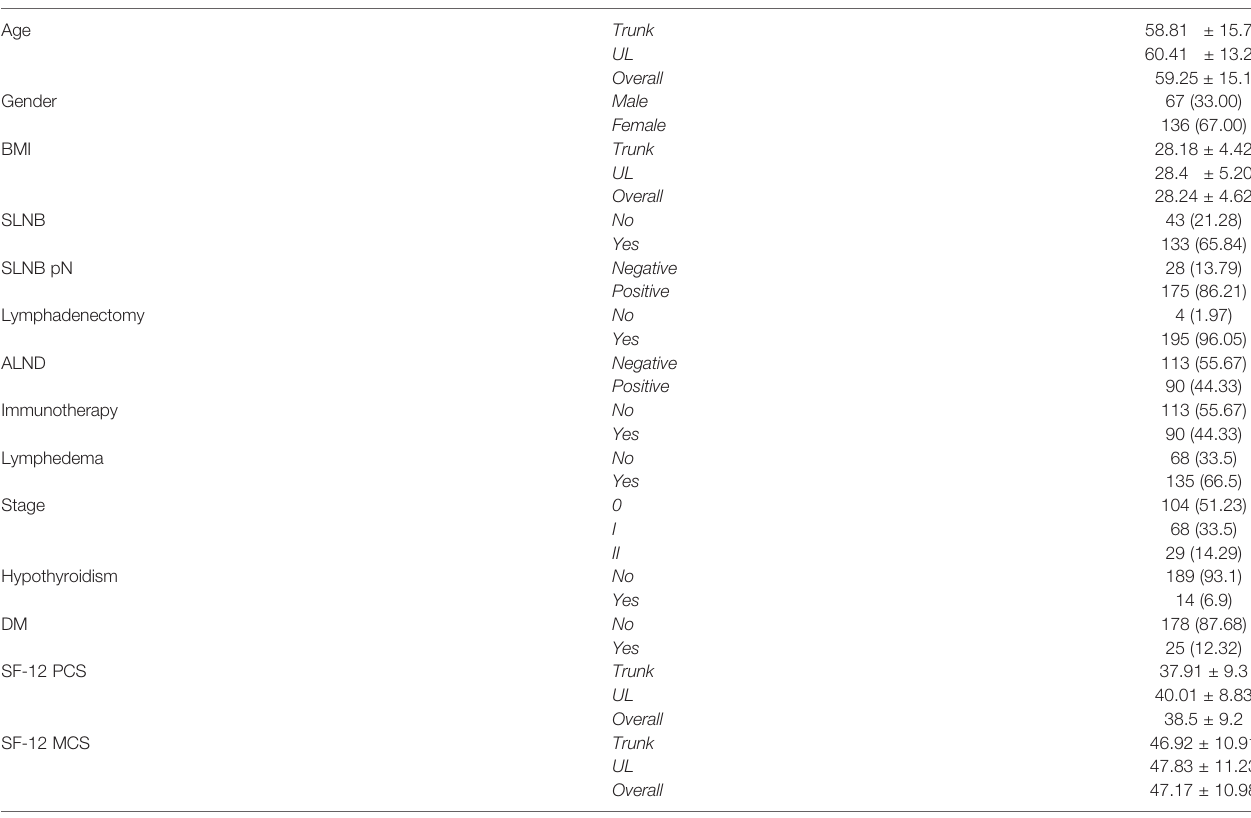
TABLE 1 | Descriptive statistics on the study cohort (n = 203).